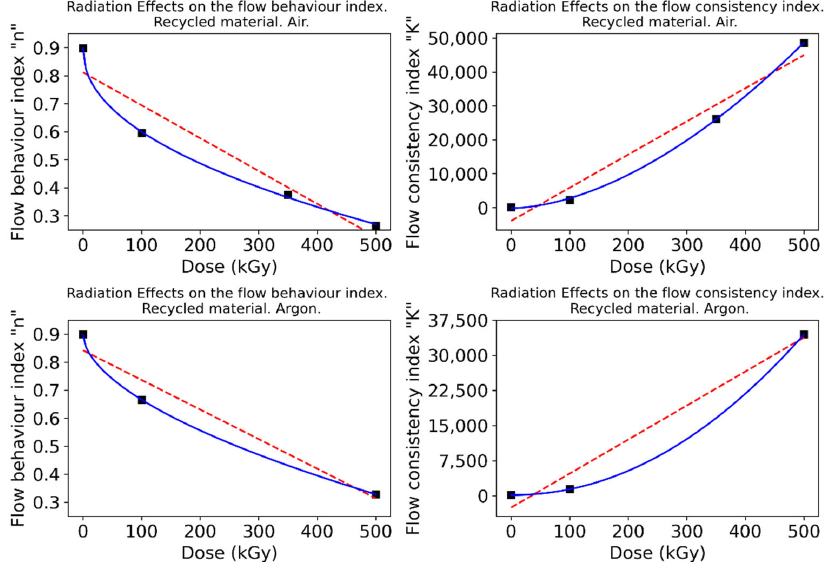
Figure 6. Dependence of the flow behavior and flow consistency indexes to the absorbed dose. Re ‐ cycled material.